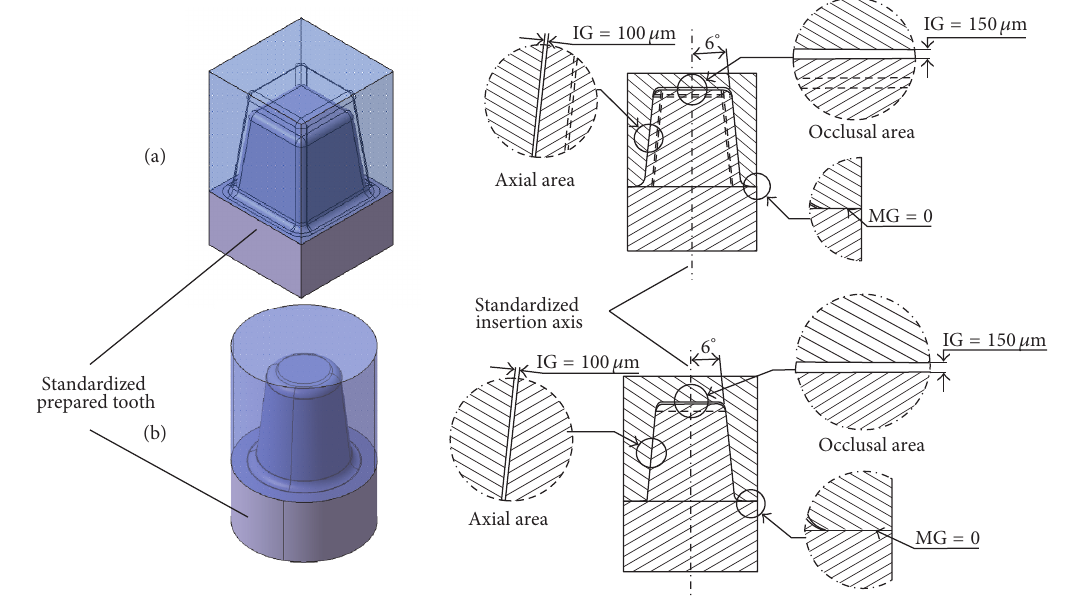
Figure 7: Standardized geometries: (a) pyramidal and (b)